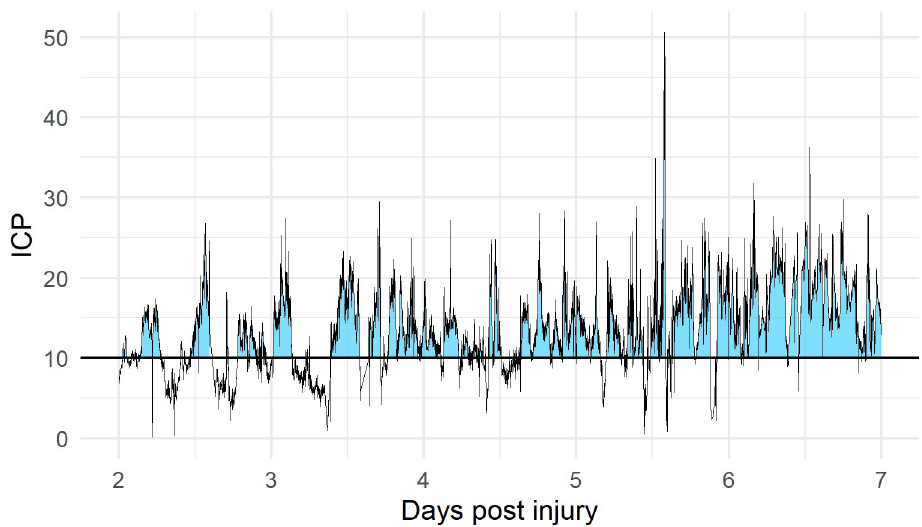
Fig 1. Calculation of AUC of ICP over time. An example of how ICP dose as pressure times time dose is represented from a representative patient. The blue-coloured area is the AUC (i.e. the ICP dose) above threshold ICP = 10 mmHg and represents the